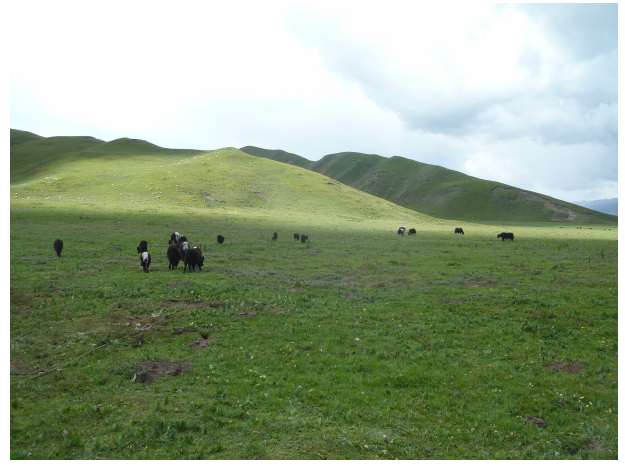
Fig. 2 . A photo of pasture from the study site to show the similarities of vegetation characteristics along the elevation